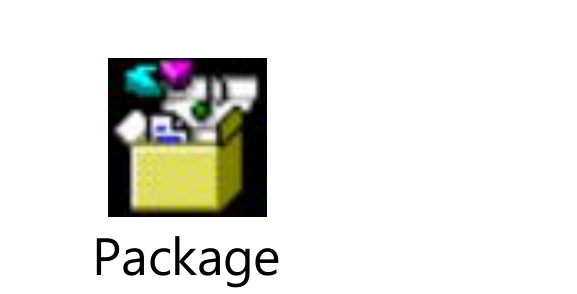
Figure A1. Data and Variable Definitions—SPSS v. 24.